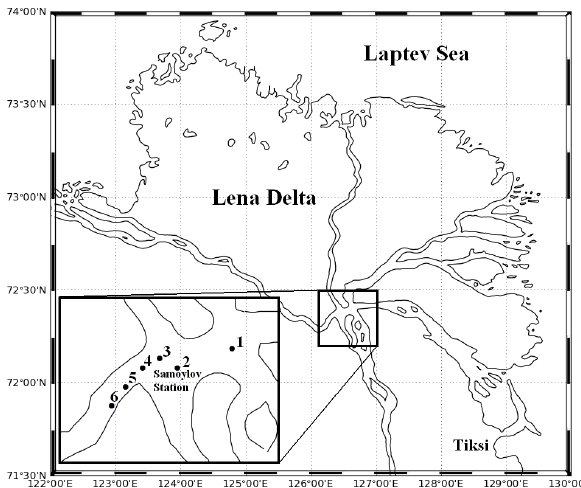
Fig. 1. Study area and location of sampling